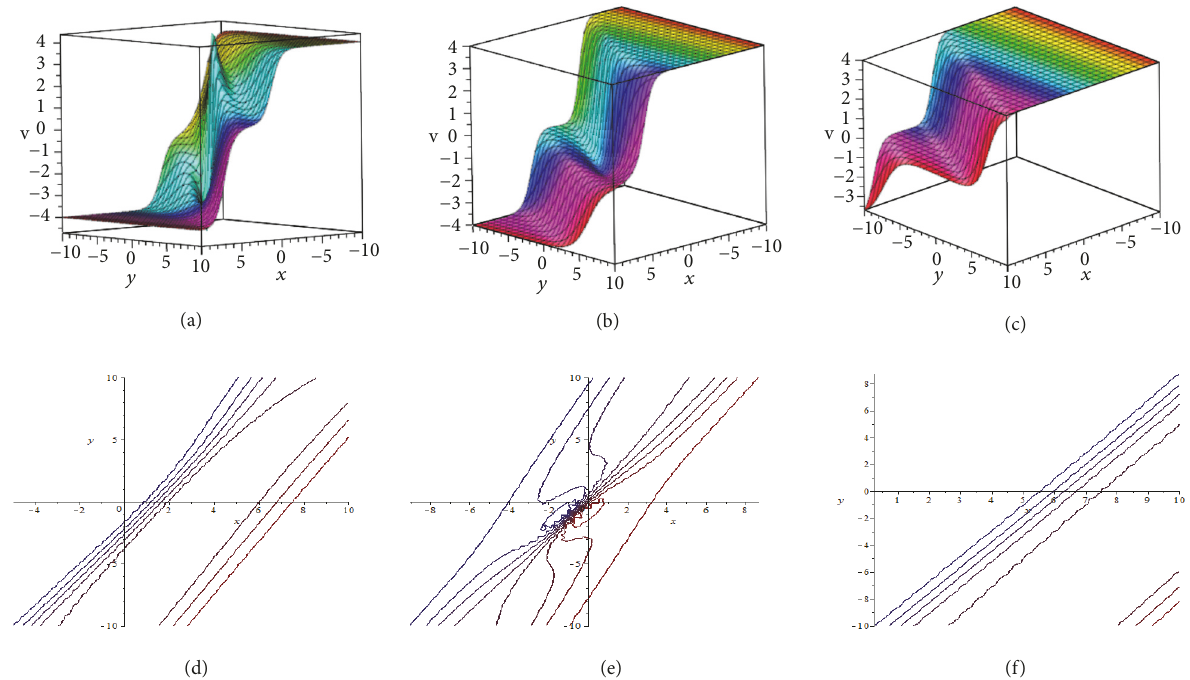
Figure 3: Upper plots: 3D plots for (14) at (a) 𝑡 = 0 , at (b) 𝑡 = 1 , and at (c) 𝑡 = 2 and 𝑧 = 0 . Contour plots (nethermost plots) for (14) at (d) 𝑡 = 0 , at (e) 𝑡 = 1 , and at (f) 𝑡 = 2 and 𝑧 =